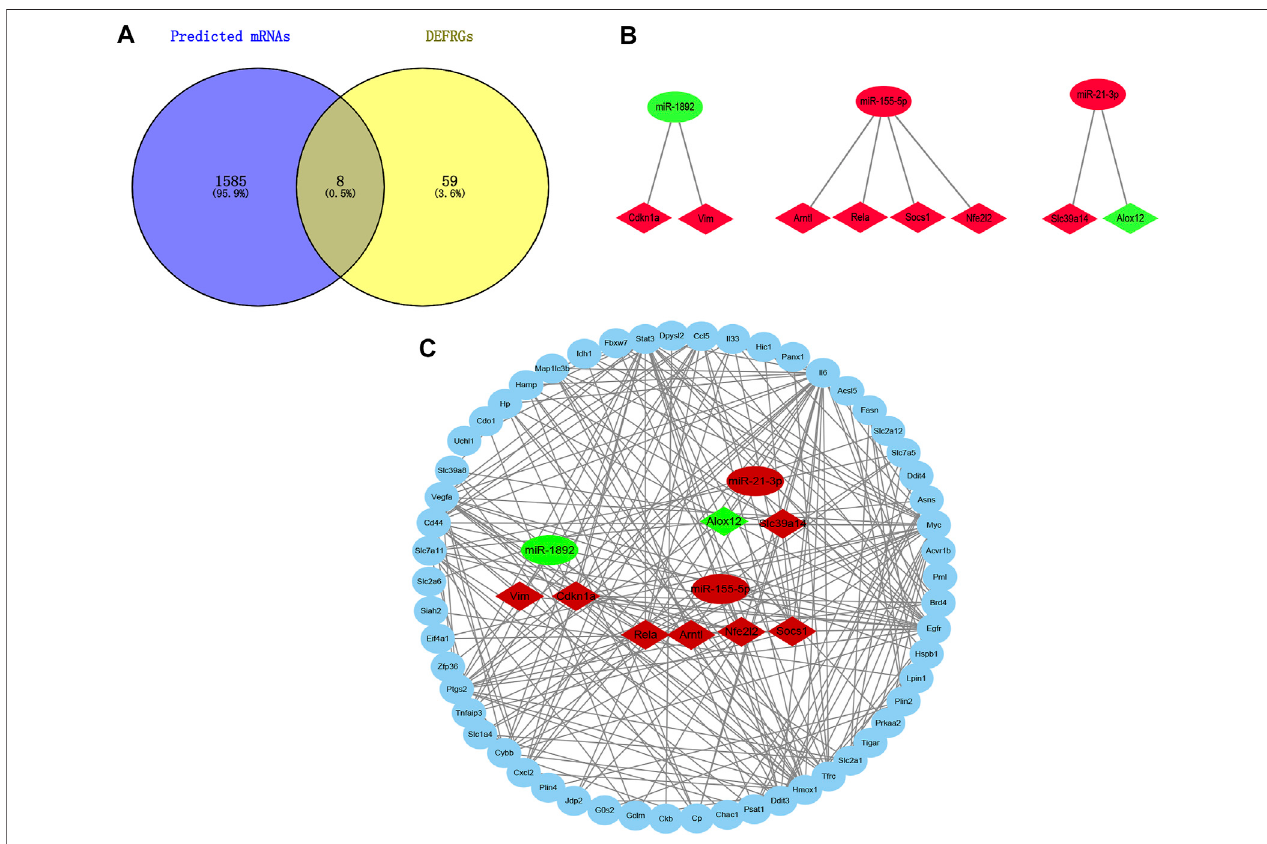
FIGURE 5 | Construction of DEmiRs-DEFRGs regulatory network. (A) Venn diagram showing the overlap of genes between predicted mRNAs and DEFRGs. (B) The miRNA- DEFRGs regulatory pairs. (C) The miRNA- DEFRGs regulatory network. DEFRGs, differentially expressed ferroptosis-related genes.